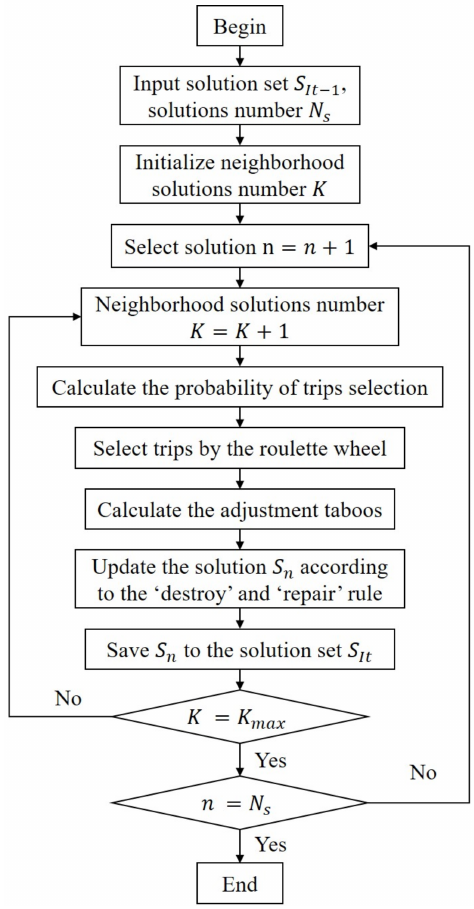
Figure 7. The flowchart of algorithm